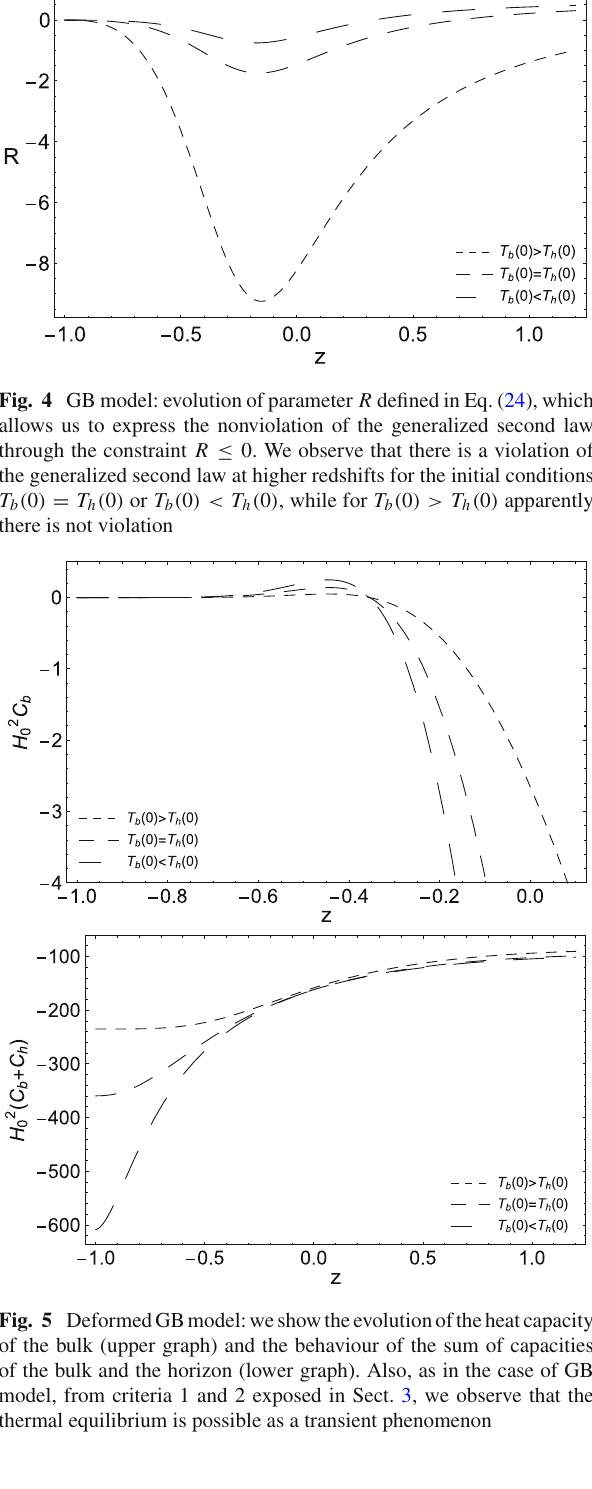
wefollowthecriteria1and2forthermalequilibriumexposed in Sect. 3. We observe also a sign change of the heat capacity of the bulk in the future, at about z (cid:10) − 0 . 3, which comes to take positive values later, being the sum of heat capacities, bulk plus boundary, always negative. Therefore we find that